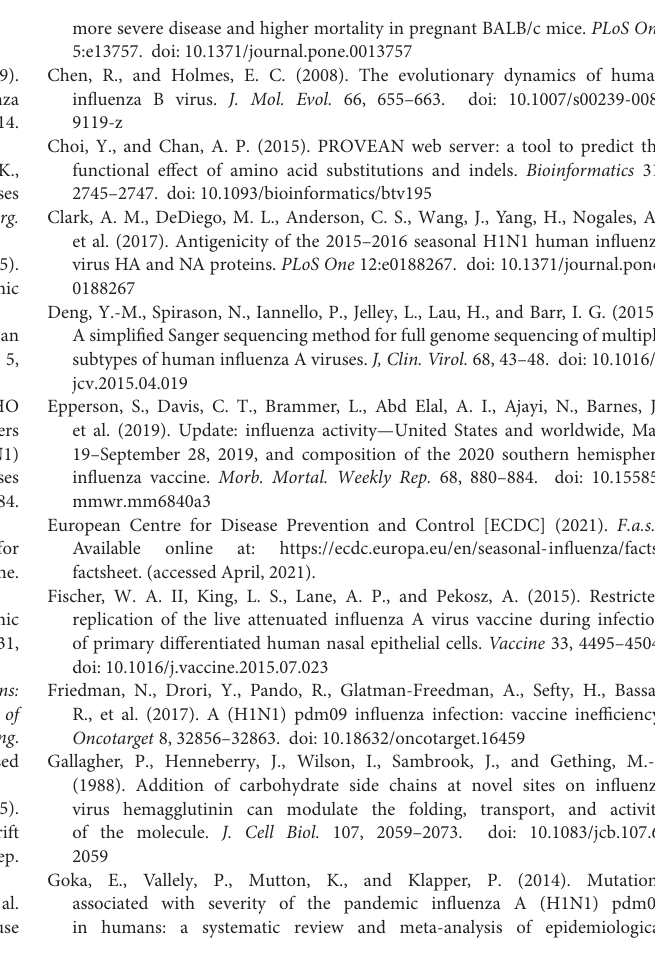
Supplementary Figure 1 | Graphical comparison between the routine and sentinel surveillance in North Macedonia. Supplementary Figure 2 | Graphical representation of reported ILI cases from 2017 to 2020 divided by age groups. Supplementary Figure 3 | Comparison of the number of reported, tested and positive SARI cases throughout the four analyzed